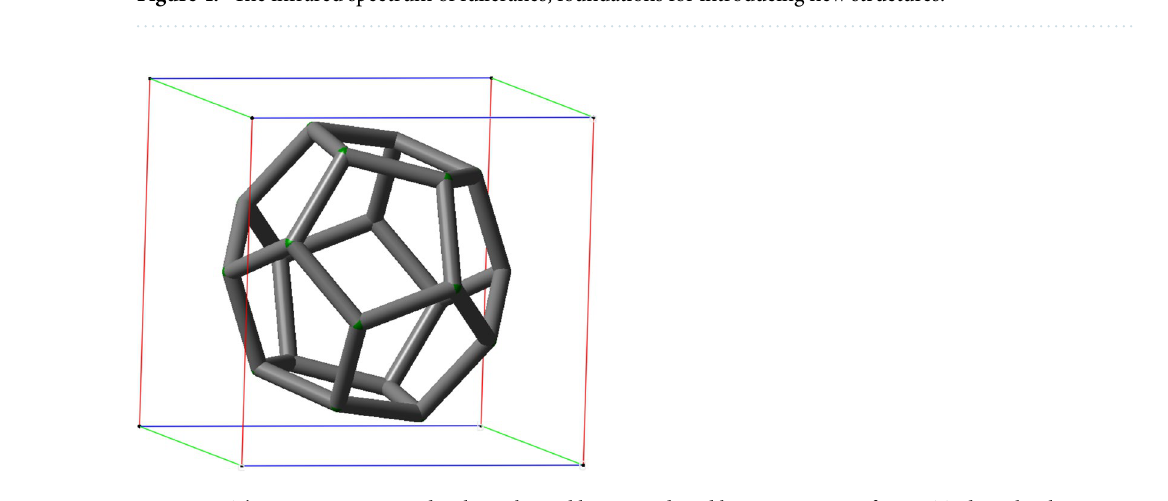
Figure 5. The C 20 structure inside a hypothetical box introduced by GaussView software. To describe the dimensions of the structures investigated in this study, we assumed that each is in a suitable box. It helps us to approximate the diameter of each structure